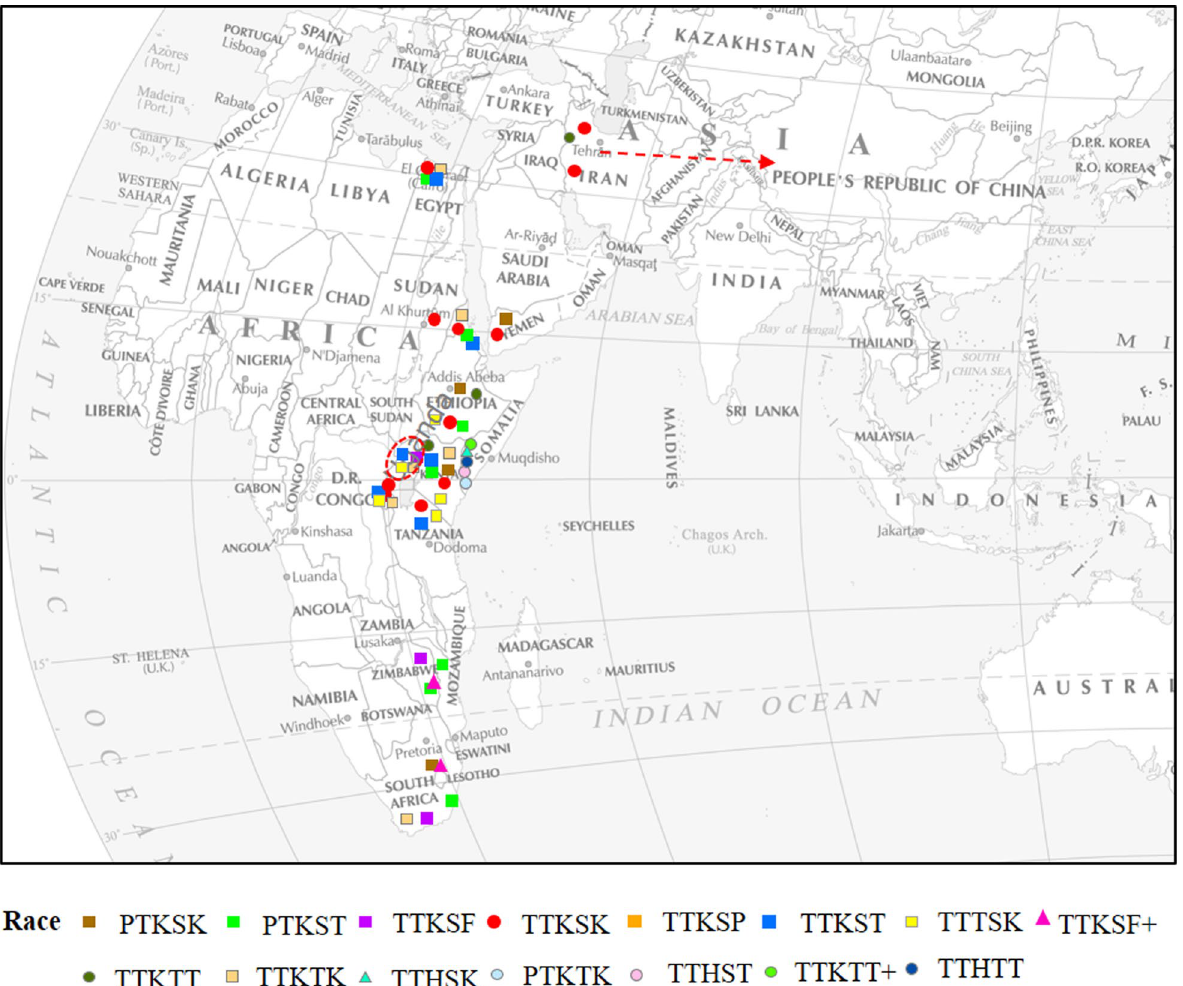
Fig. 8 The re-labelled map sketch illustrating origin (Uganda indicated by red-dotted circle), evolution and dispersal of the Puccinia graminis f. sp. tritici race TTKSK (Ug99) lineage and potential invasion risk to China. Data resource: CIMMYT, September 2021 at https:// rustt racker. cimmyt. org/? page_ id =